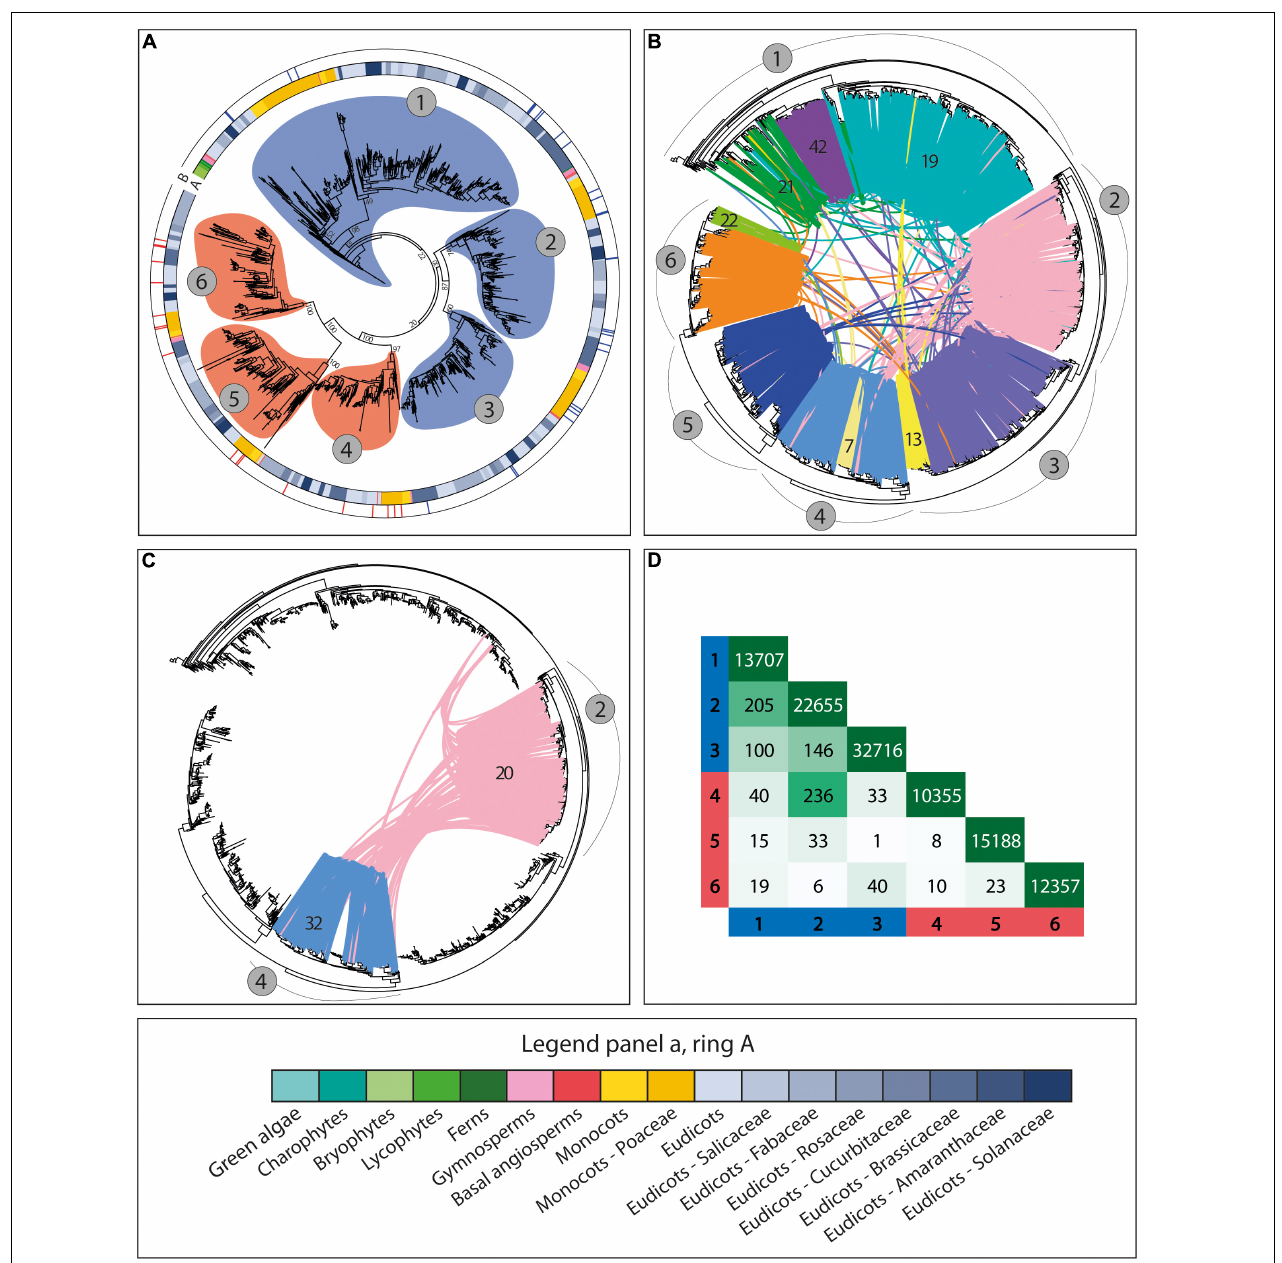
FIGURE 3 | The phylogenomic structure of the CesA family. (A) The phylogenetic tree of all the CesA genes from the 193 genomes with a BUSCO representation ≥ 75% and at least five genes per scaffold on average. The tree highlights the subdivision of the CesA sequences into six main phylogenetic groups corresponding to known primary and secondary cell wall CesA isoforms from different species. Rings A and B, respectively, represent the species taxonomy of the different genes (legend at the bottom of the figure) and the tree position of 49 experimentally validated primary (blue) and secondary (red) cell wall CesA genes. Circles around tree branches highlight the six major CesA clades detected in the tree, divided into three primary (blue) and three secondary (red) cell wall CesA clades. (B) The phylogenetic tree of all the CesA genes as in panel A, with highlighted the syntenic connections between genes and the different syntenic communities detected. Lines connecting tree leaves indicate syntenic connections between genes, with different colours highlighting different syntenic communities. Numbers in grey circles refer to gene clades as in panel A, while numbers on coloured syntenic connections indicate community numbers as referred in the article. The figure shows that the six major CesA clades of panel A are arranged into distinct conserved architectural genomic configurations (or genomic contexts). (C) Highlight of the syntenic connections between clades 2 (pink; primary cell wall CesA genes) and 4 (blue; secondary cell wall CesA genes). The pink links between the two phylogenetic clades indicate secondary cell wall CesA genes placed in genomic contexts typical of primary cell wall CesAs . These sequences come mostly from the Malvaceae family, and specifically from the three cotton species therein: G. hirsutum , G. arboreum, and G. raimondii . In G. hirsutum , the species involved in these connections were shown to be at the basis of the massive fibre deposition observed in cotton. (D) Total number of syntenic connections detected between the six clades of CesA genes as represented in the tree of panel A. Row and column headers refer to the six clades of the tree in panel A.